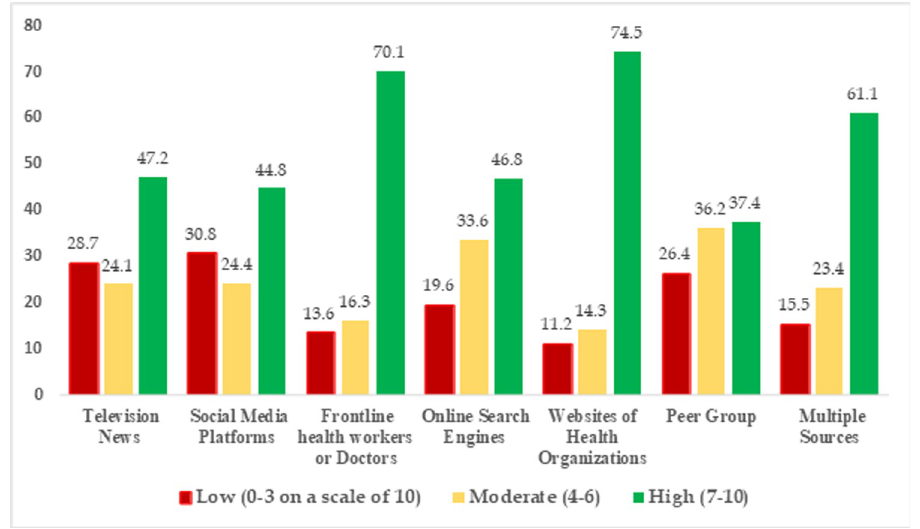
Fig 5. Perceived reliability (%) of various sources among the participants (n = 572) for seeking information on food and nutrition during COVID-19.